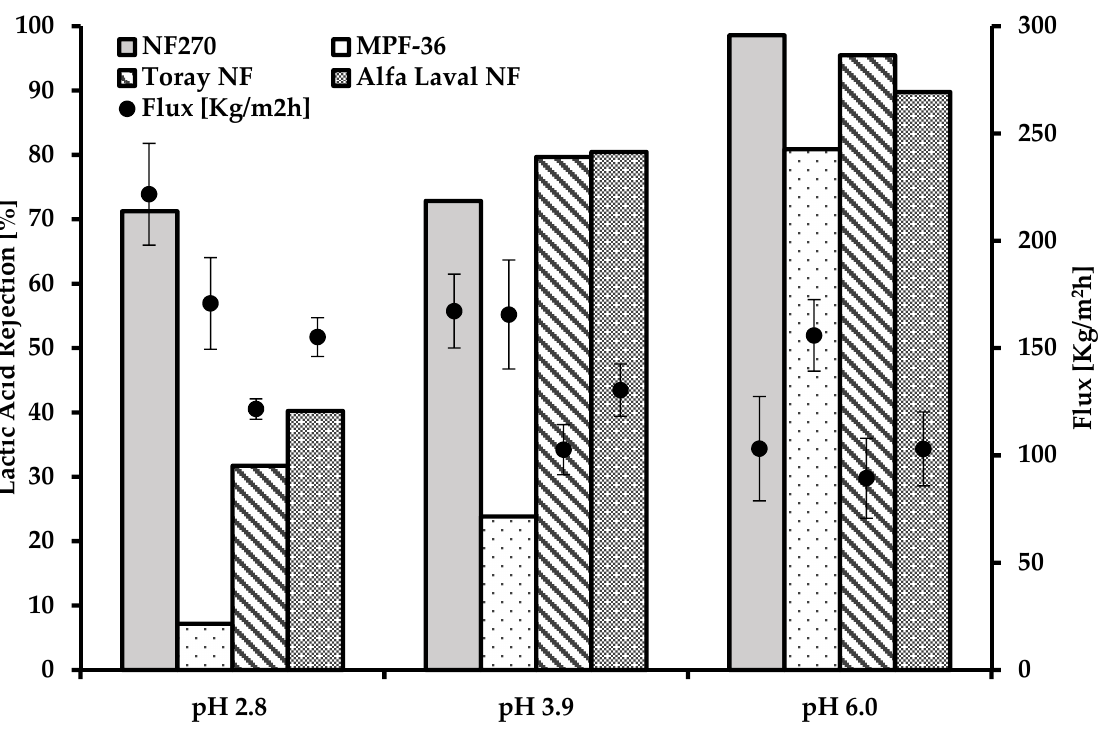
Figure 6. Rejection of lactic acid at different pH.